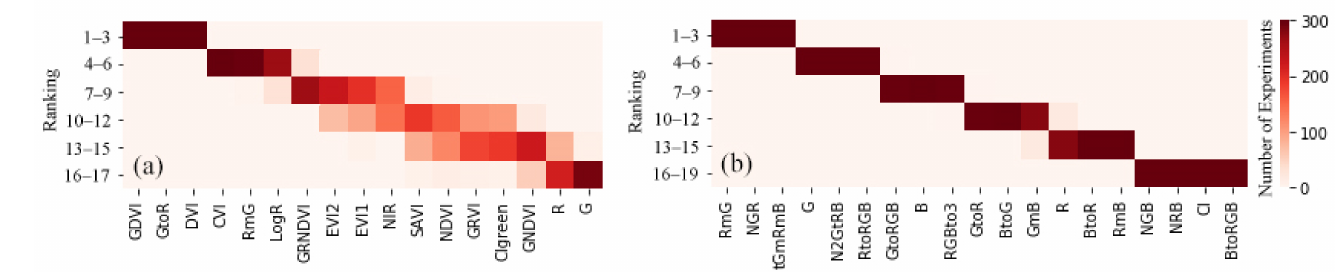
Figure 9. Statistics of VI rankings in 300 experiments using 0.007 m GSD data from ( a ) multispectral sensor and ( b ) RGB sensor.